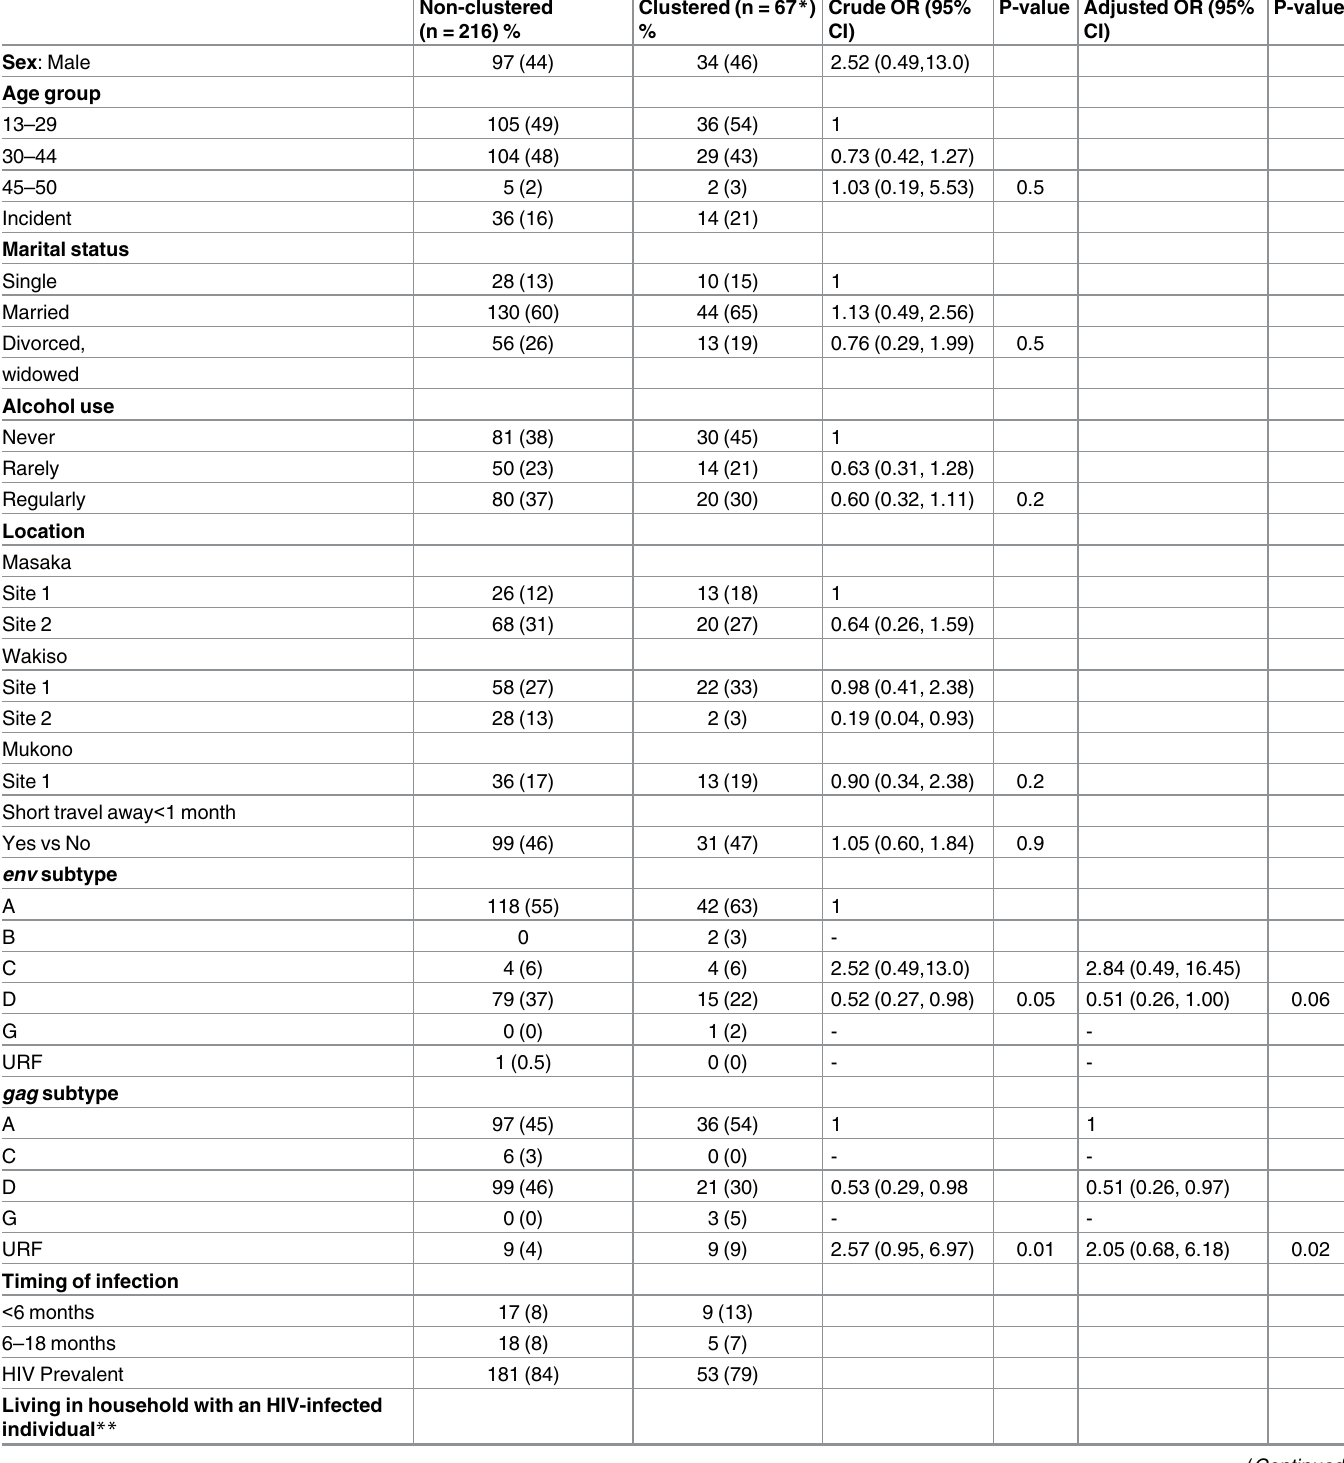
Table 4. Characteristics of sequenced data 34 clusters (n =